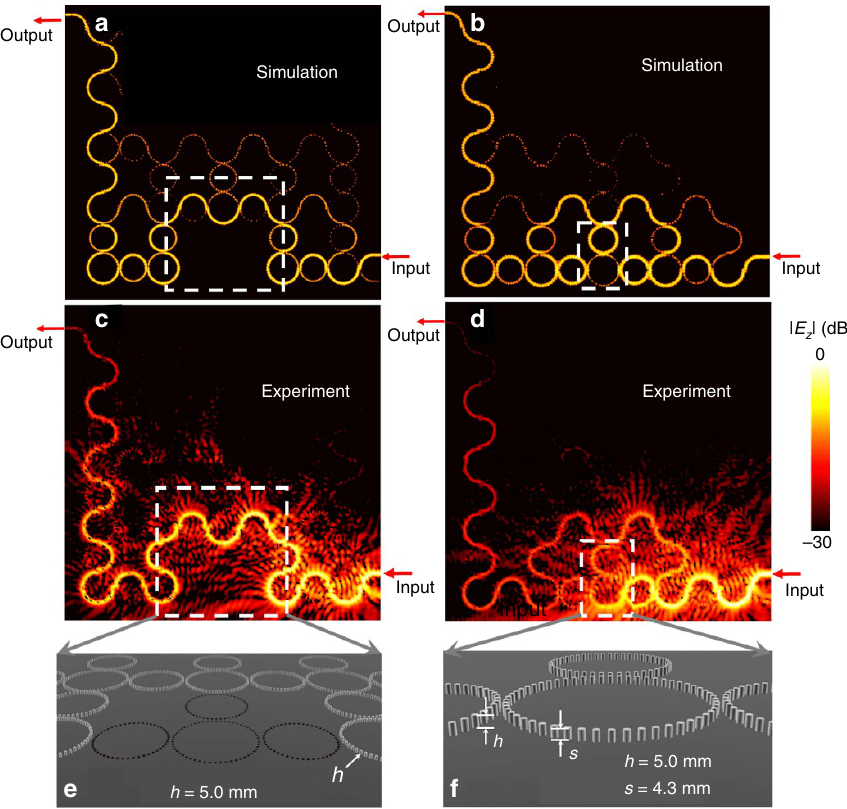
Table 1 | Summary of testing results on topological protection against defects. Defect no. Figure Defect type Fig. 5d Rod height decreased to 4.3mm Low potential barrier Fig. 4g Rod height decreased to 3.5mm Medium potential barrier Fig. 5c Rings removed Infinite potential barrier Fig. 6b Rod heights gradually decreased Dissipation Fig. 7c Metallic block approached Partial flip of spin/modulation Fig. 7d Metallic block inserted Complete flip of